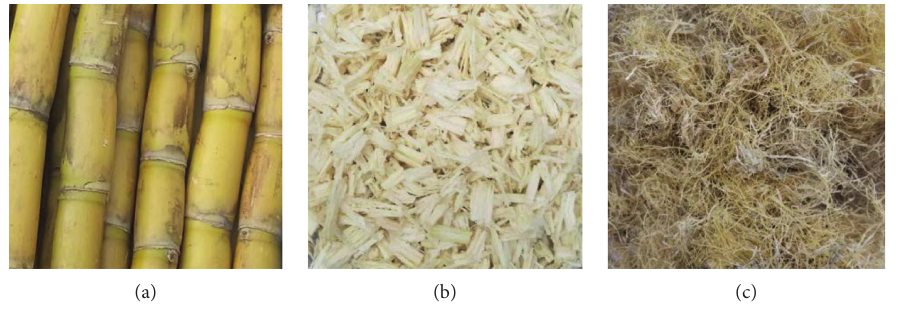
Figure 1: Bagasse fiber extraction.